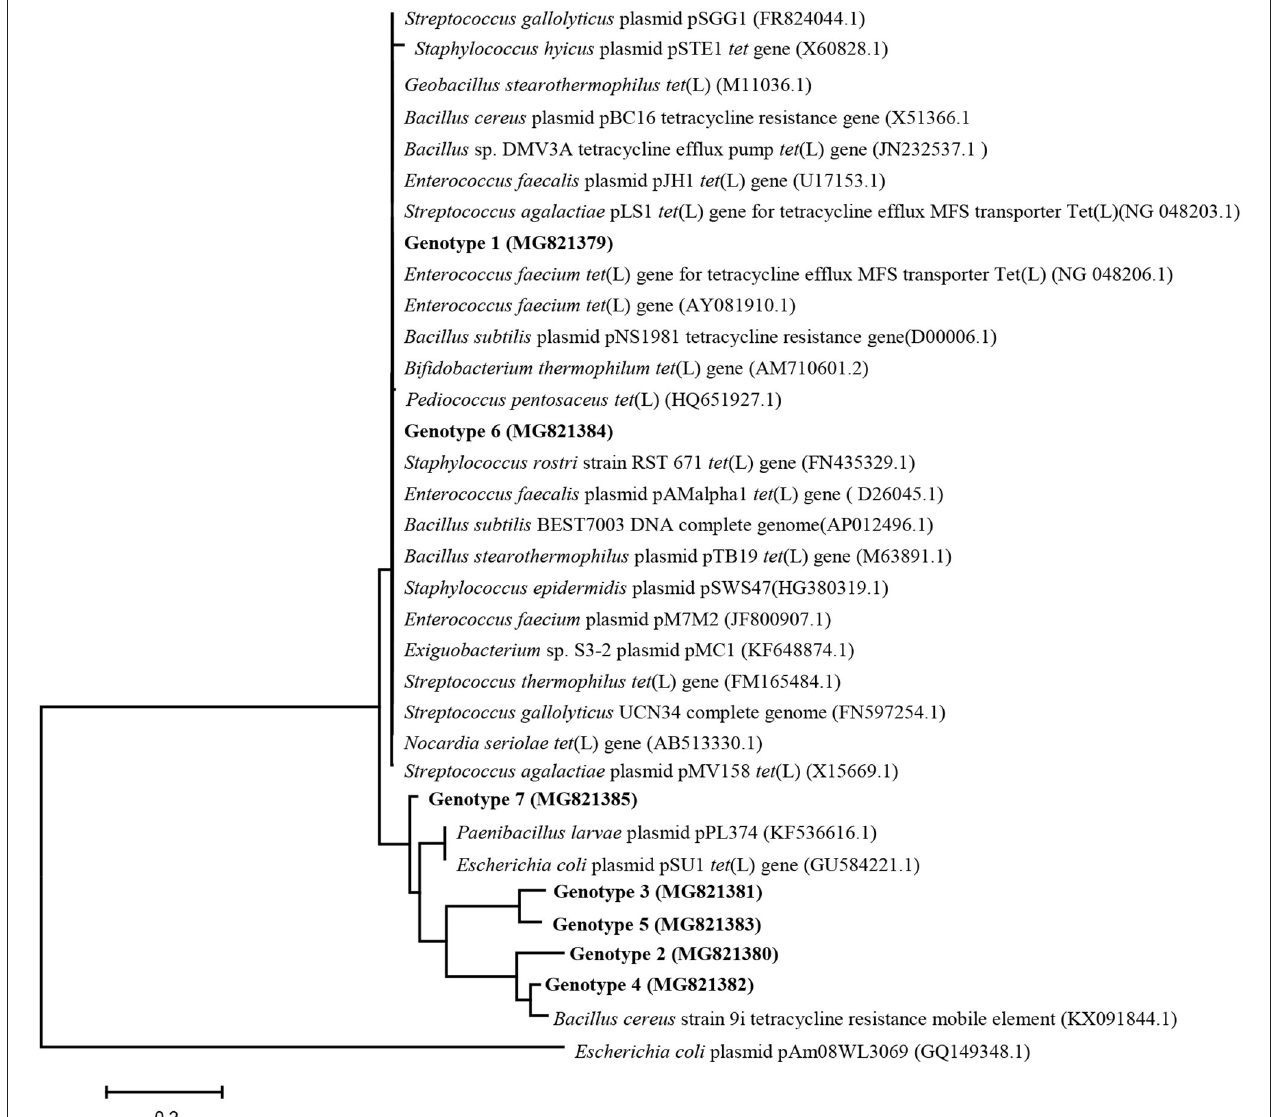
FIGURE 5 | Neighbor-joining phylogenetic analysis of genotypes genotype 1 ∼ 7 of tet (L) displayed in bold font. The sequences in GenBank that were most similar to genotype1–genotype 7 were retrieved for phylogenetic tree construction. The tree was constructed using MEGA version 5.1, and bootstrap analysis with 500 replicates was used to evaluate the significance of the